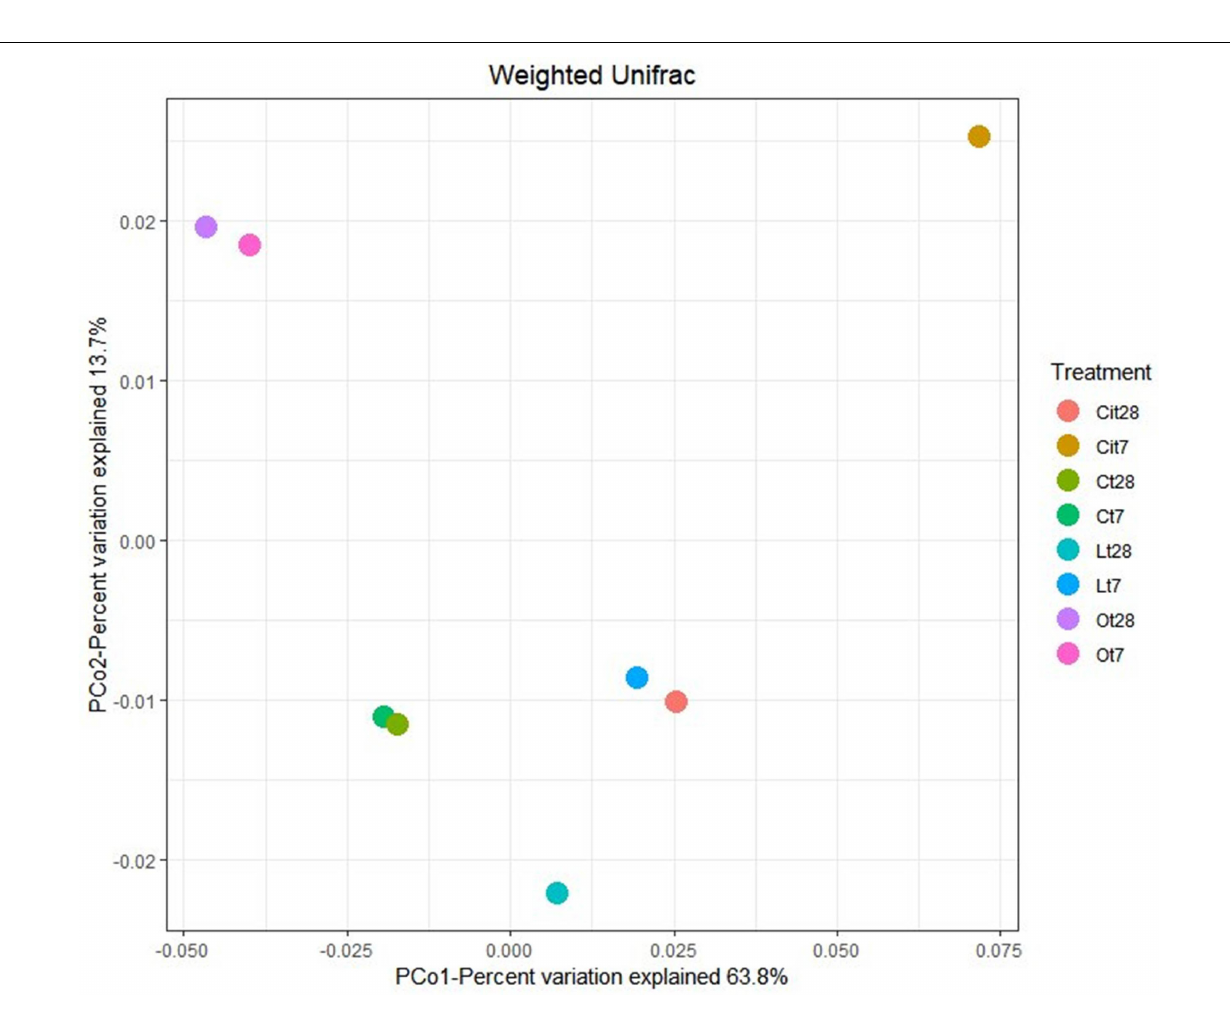
Frontiers in Plant Science |